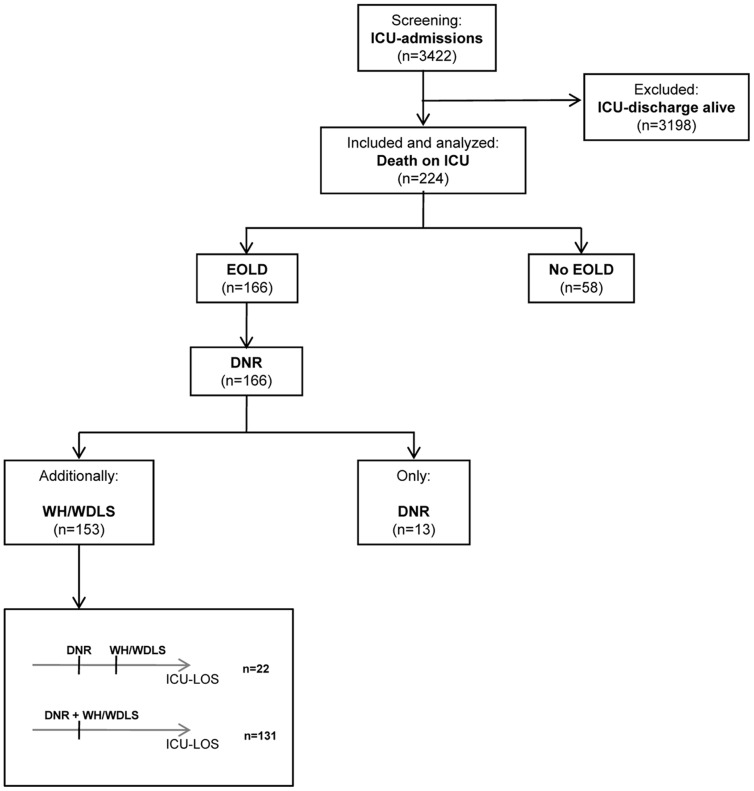
Consort diagram.